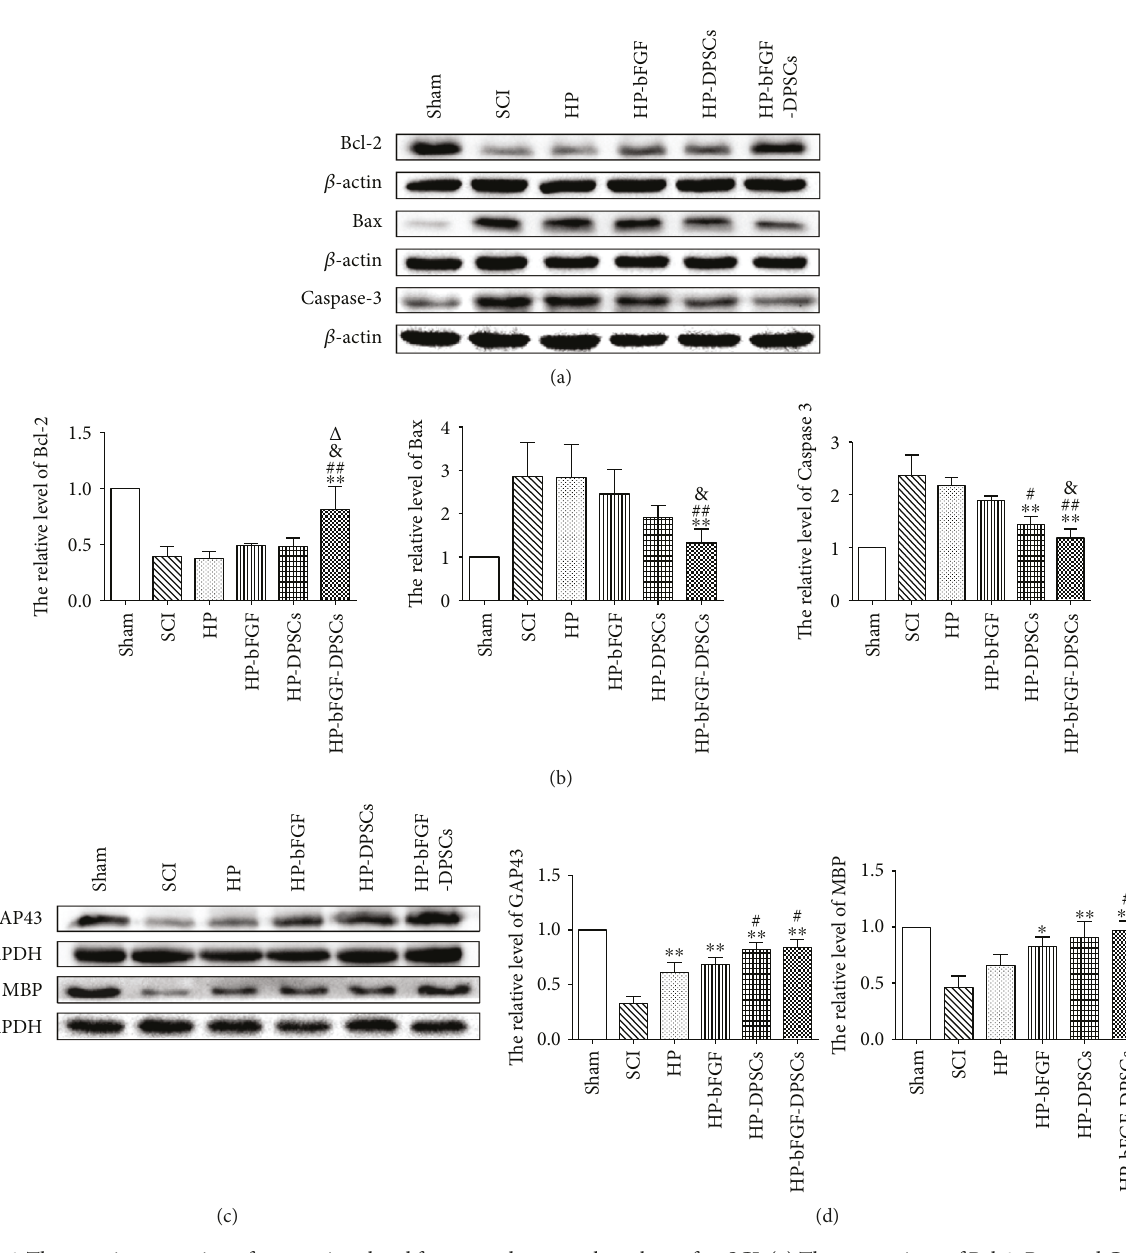
Figure 6: The protein expression of apoptotic-related factors and neuronal markers after SCI. (a) The expressions of Bcl-2, Bax, and Caspase- 3 at day 7 after SCI. (b) Quanti fi cation of Bcl-2, Bax, and Caspase-3 expression levels. (c) The expressions of MBP and GAP43 at day 21 after SCI. (d) Quanti fi cation of MBP and GAP43 expression levels. ∗ P < 0 05 , ∗∗ P < 0 01 versus SCI group; # P < 0 05 , ## P < 0 01 versus HP group; & P < 0 05 versus HP-bFGF group; Δ P < 0 05 versus HP-DPSCs